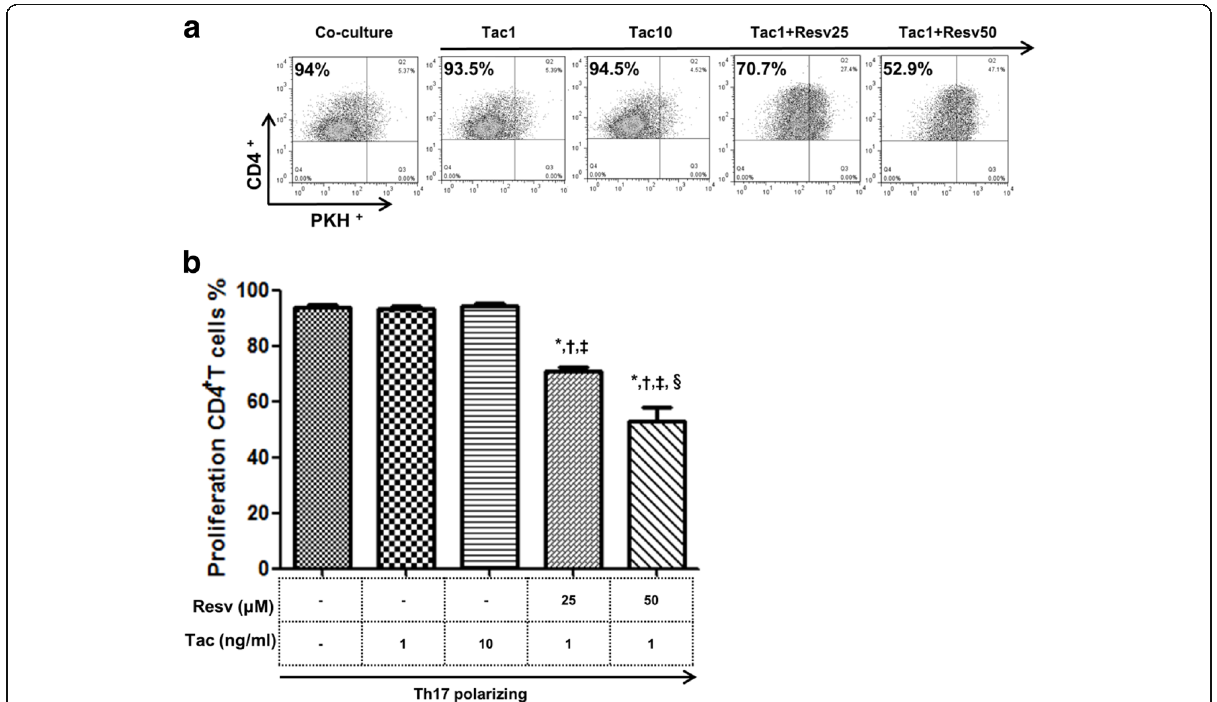
Fig. 4 Suppressive effects of Resv on HRPTEpiC-reactive proliferation of CD4 + PKH − T cells. We co-cultured PKH-67 labeled T cells with HRPTEpiCs and analyzed the differentiation of T cells by counting PKH ( − ) T cells. ( a ) The percentage of target cells was measured via flow cytometry. ( b ) The proportion (%) of proliferating CD4 + T cells. Bars show means. *P < 0.05 vs. Th17 polarizing condition † P < 0.05 vs. Tac 1 ng/mL group ‡ P < 0.05 vs. Tac 1 ng/mL group § P < 0.05 vs. Tac 1 ng/mL + Resv 25 μ M group. Resv, Resveratrol; Tac,